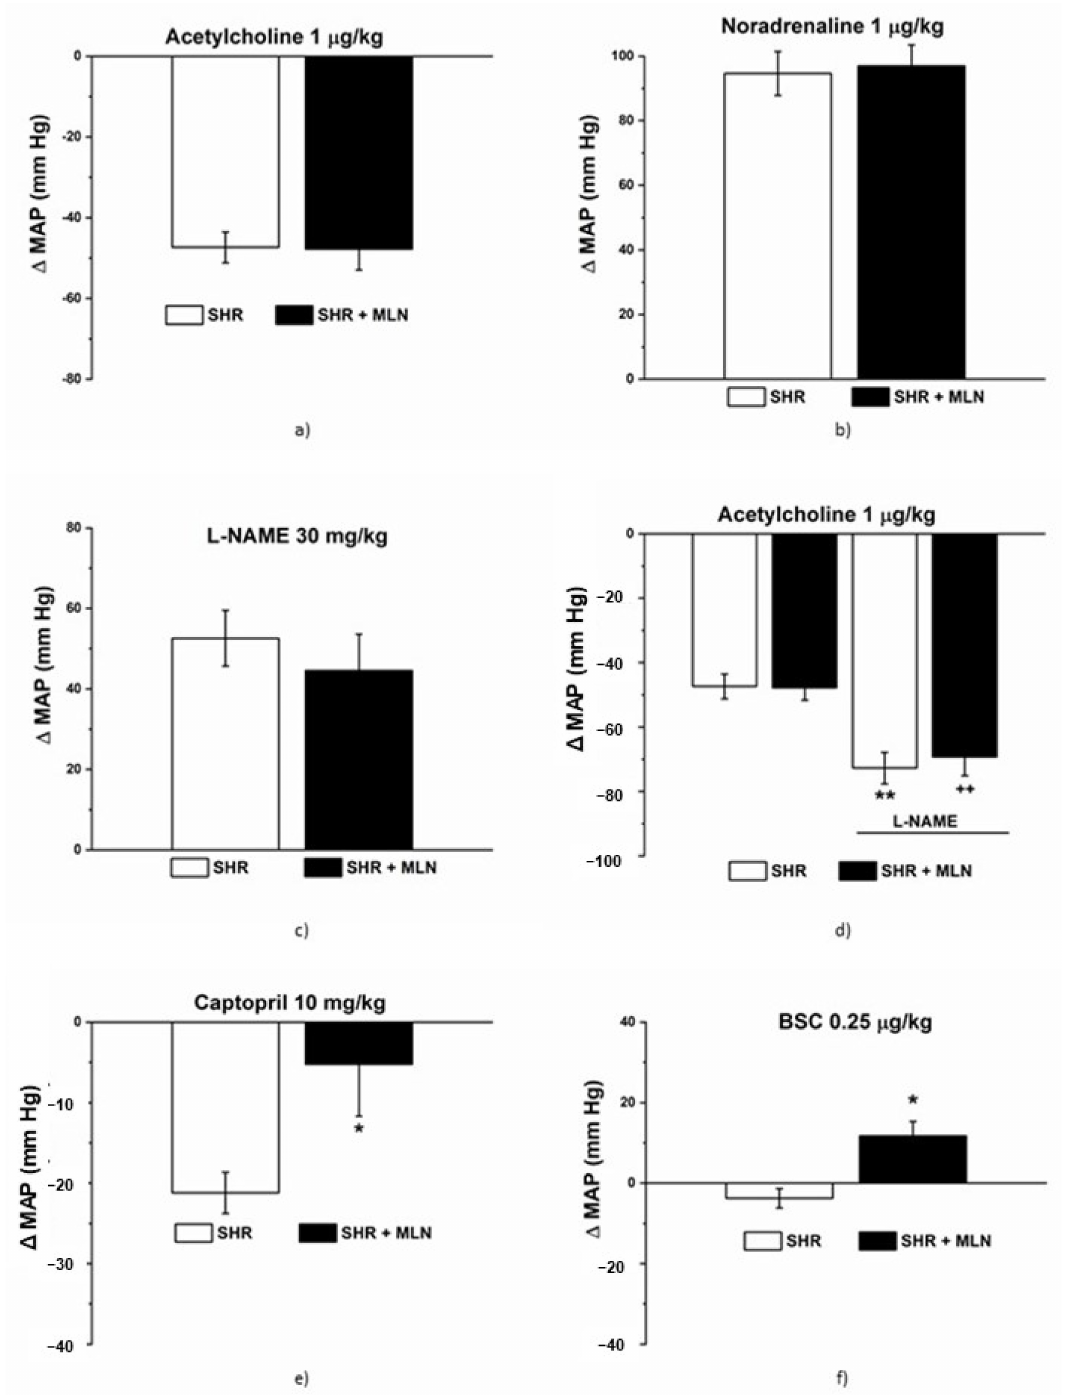
Figure 3. The effect of MLN-4760 treatment on the integrated pressure responses of the cardiovascular system. The changes in mean blood pressure ( ∆ MAP) were followed after infusion of acetylcholine (1 µ g/kg, ( a )), noradrenaline (1 µ g/kg, ( b )), NOS inhibitor (L-NAME, 30 mg/kg, ( c )), ACE inhibitor- captopril (10 mg/kg, ( e )) and H 2 S scavenger bismuth(III) subsalicylate (BSC, 0.25 µ g/kg, ( f )). The effect of acetylcholine (1 µ g/kg) also was followed before and after pretreatment with L-NAME (30 mg/kg, ( d )). The results are presented as the mean ± S.E.M., and differences between groups were analyzed by Student ´ s t -test. * p < 0.05, ** p < 0.01 vs. SHR; ++ p < 0.01 vs. SHR +